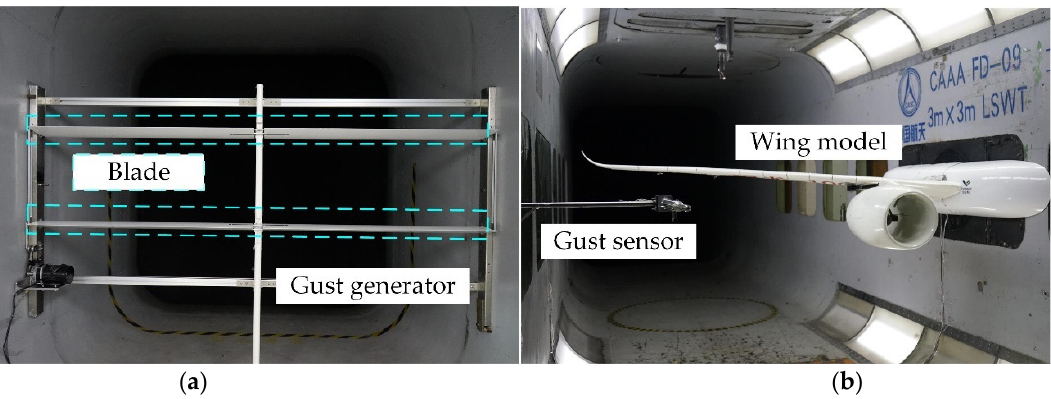
Figure 12. Wing model and gust generator in wind tunnel test: ( a ) gust generator; ( b ) wing model.